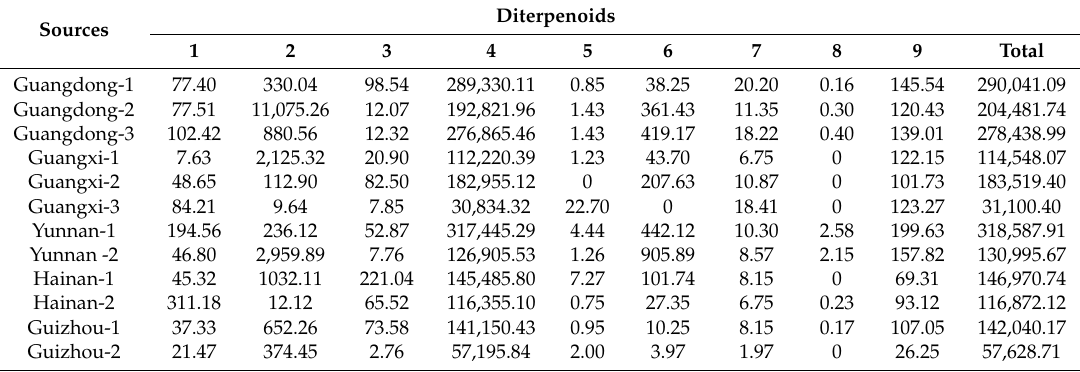
Table 3. The contents of nine diterpenoids in C. crassifolius from different sources ( n = 3, µ g/g).